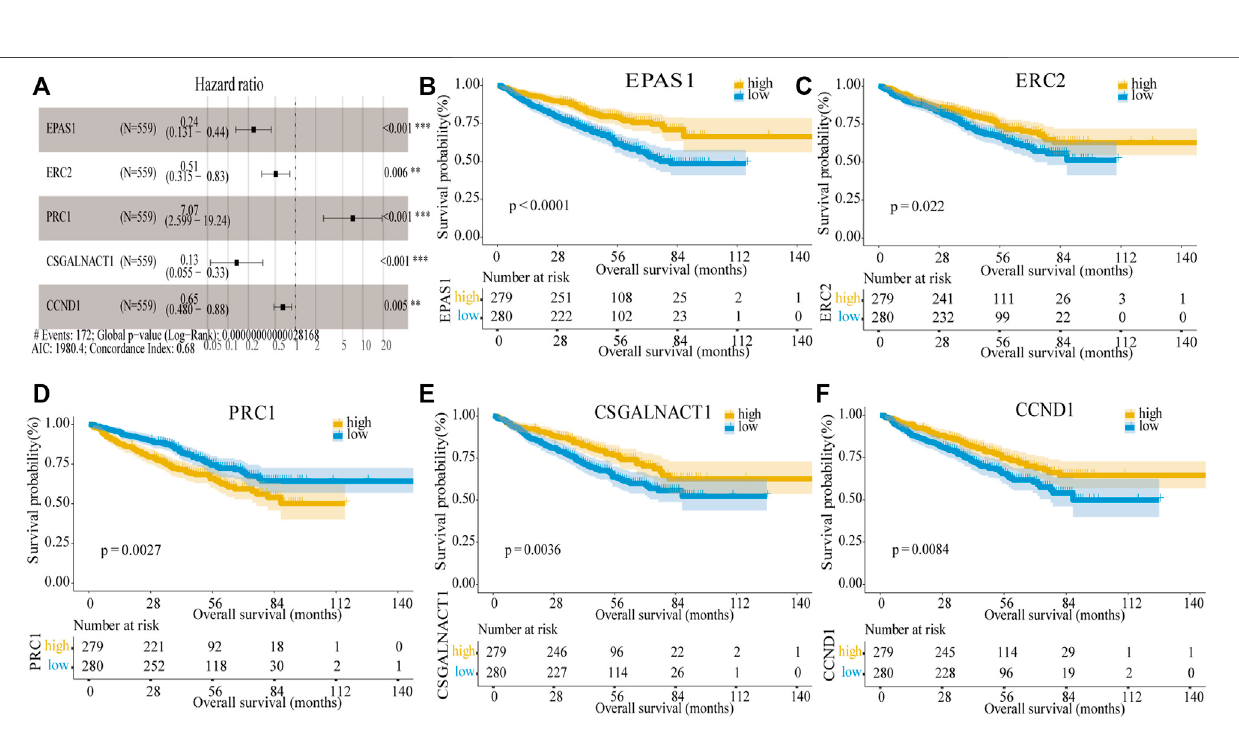
Frontiers in Genetics |